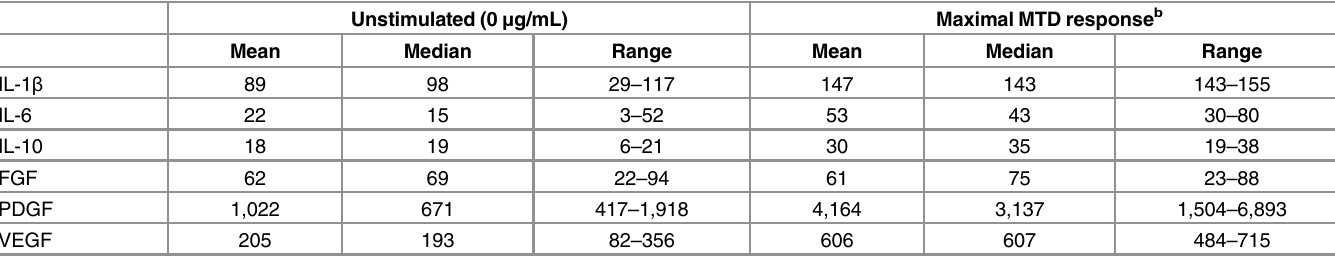
Table 1. Cytokine and Growth Factor Levels in Cell Culture Supernatants a .